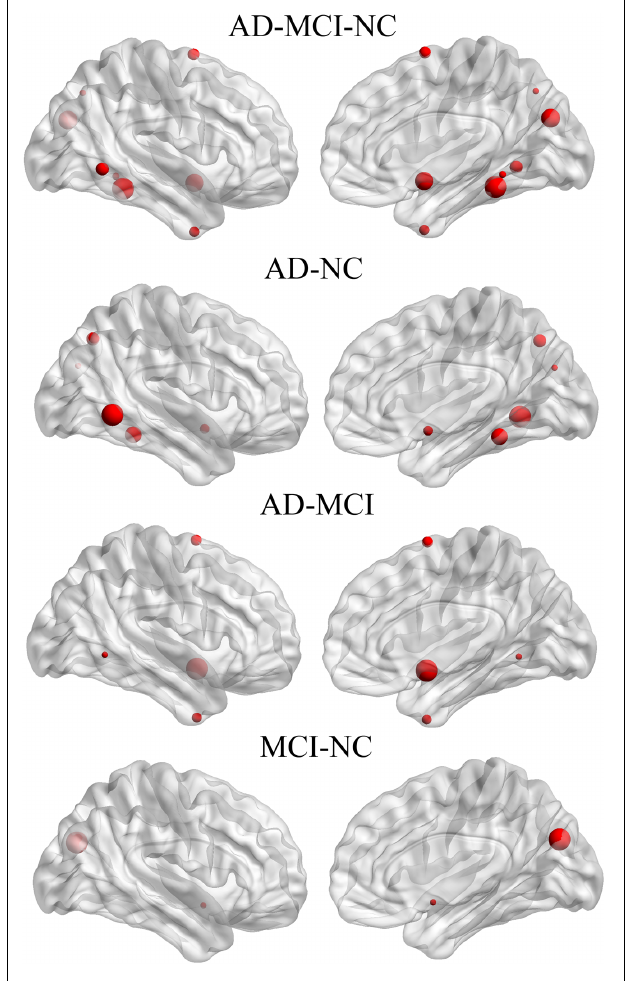
FIGURE 6 | Three-dimensional representations of the nodes with significant between-group differences in the AI of nodal efficiency. The node size represents the F -value of GLM when comparing the AI of nodal efficiency among the three groups, and represents the t -value of post hoc analysis (no FDR).